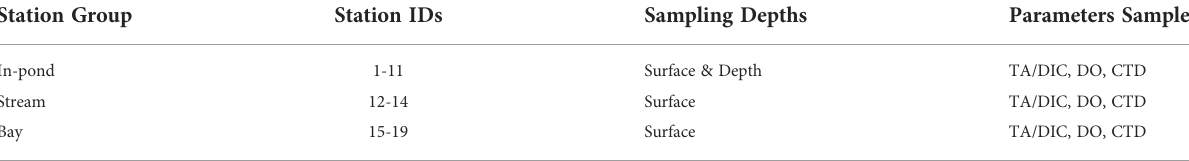
TABLE 1 Station groups by geographic location with referenced station IDs, sampled depths, and measured parameters. Station